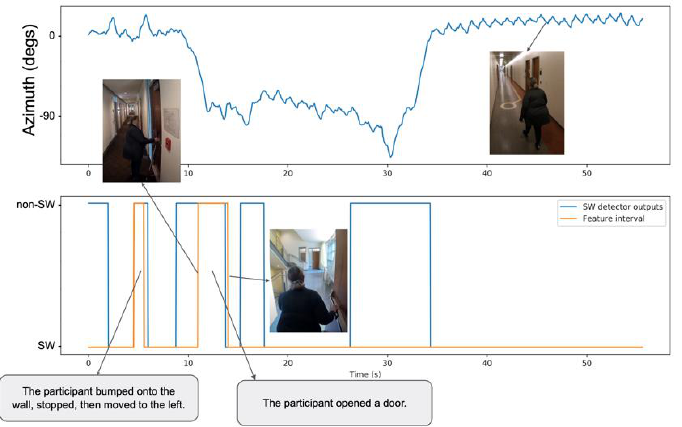
Figure 3. Example of SW segment detection using our GRU system. Top: Azimuth signal; Bottom: output of SW detector (blue line), shown together with the segments marked as “features” in WeAllWalk (orange line).